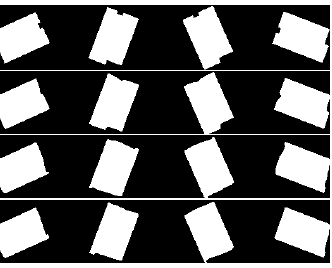
Figure 6. Building Polygons from